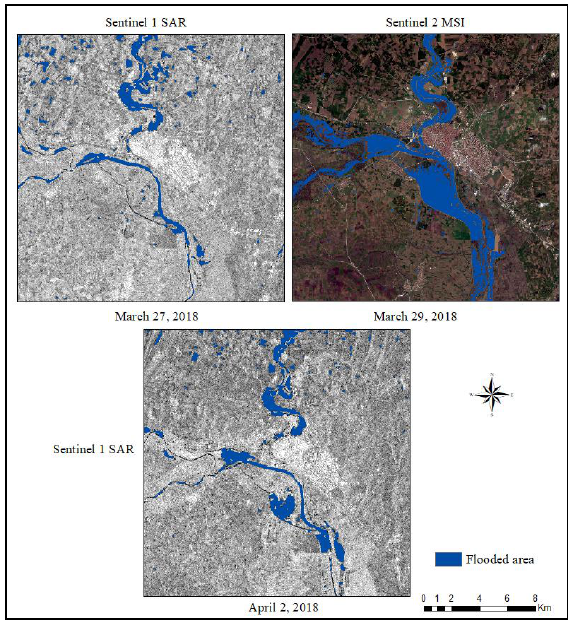
Figure 2. Example of satellite dataset used for the latest flood of March 25, 2018.